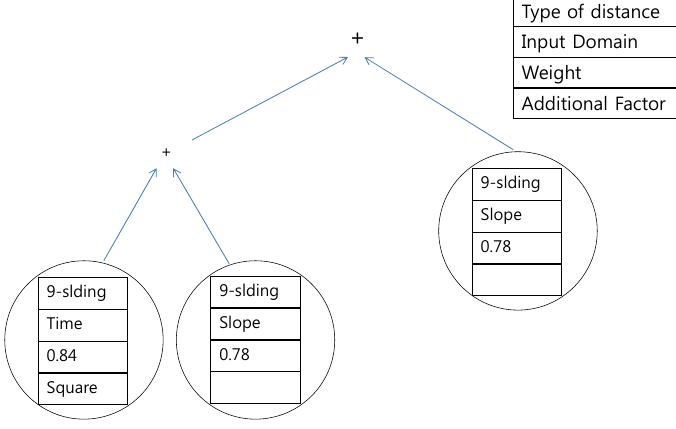
Figure 20. Proposed tree for the northern region using the data of experts #1 and